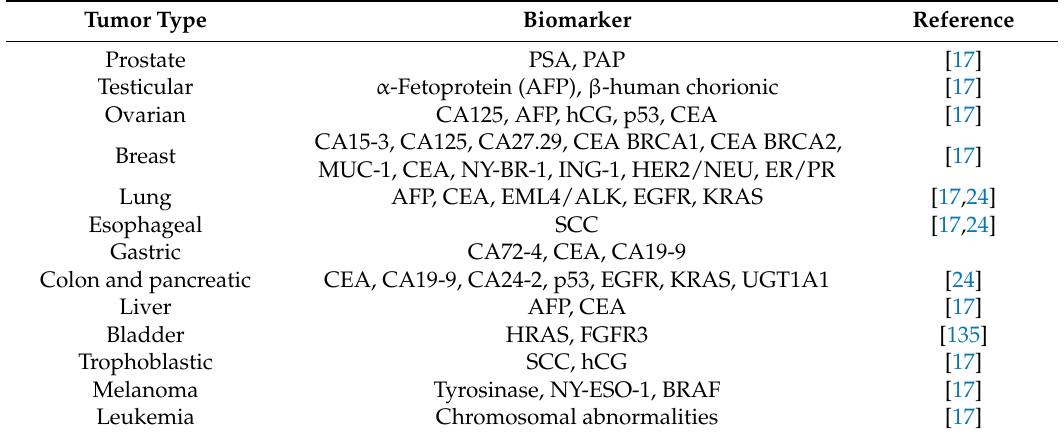
Table 2. Known biomarkers according to type of tumor [17,24,135].